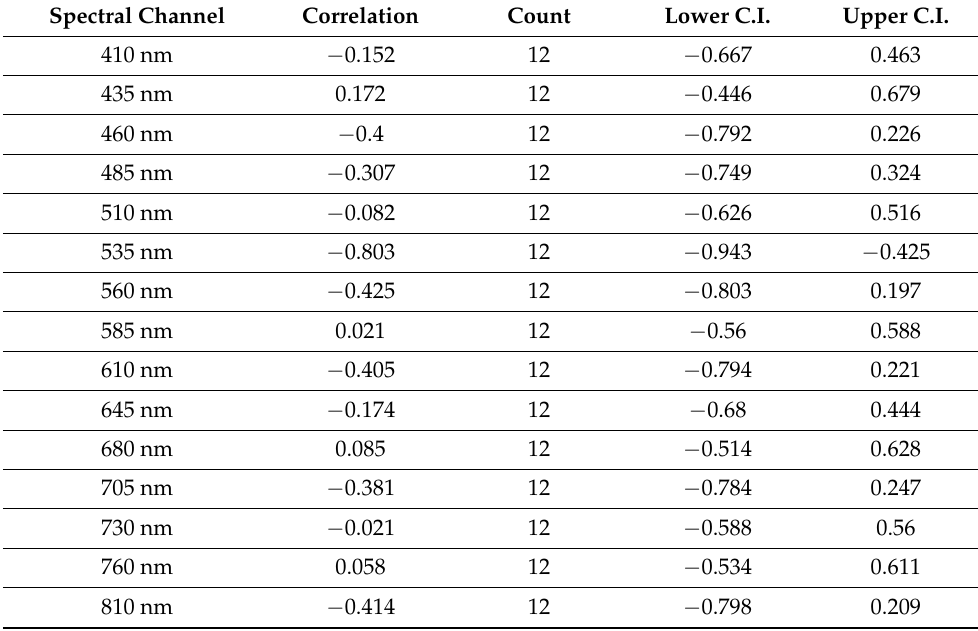
Table A2. The average spectral intensity for each channel per day according to the combined data of Tank L and Tank S and their correlation with the potassium